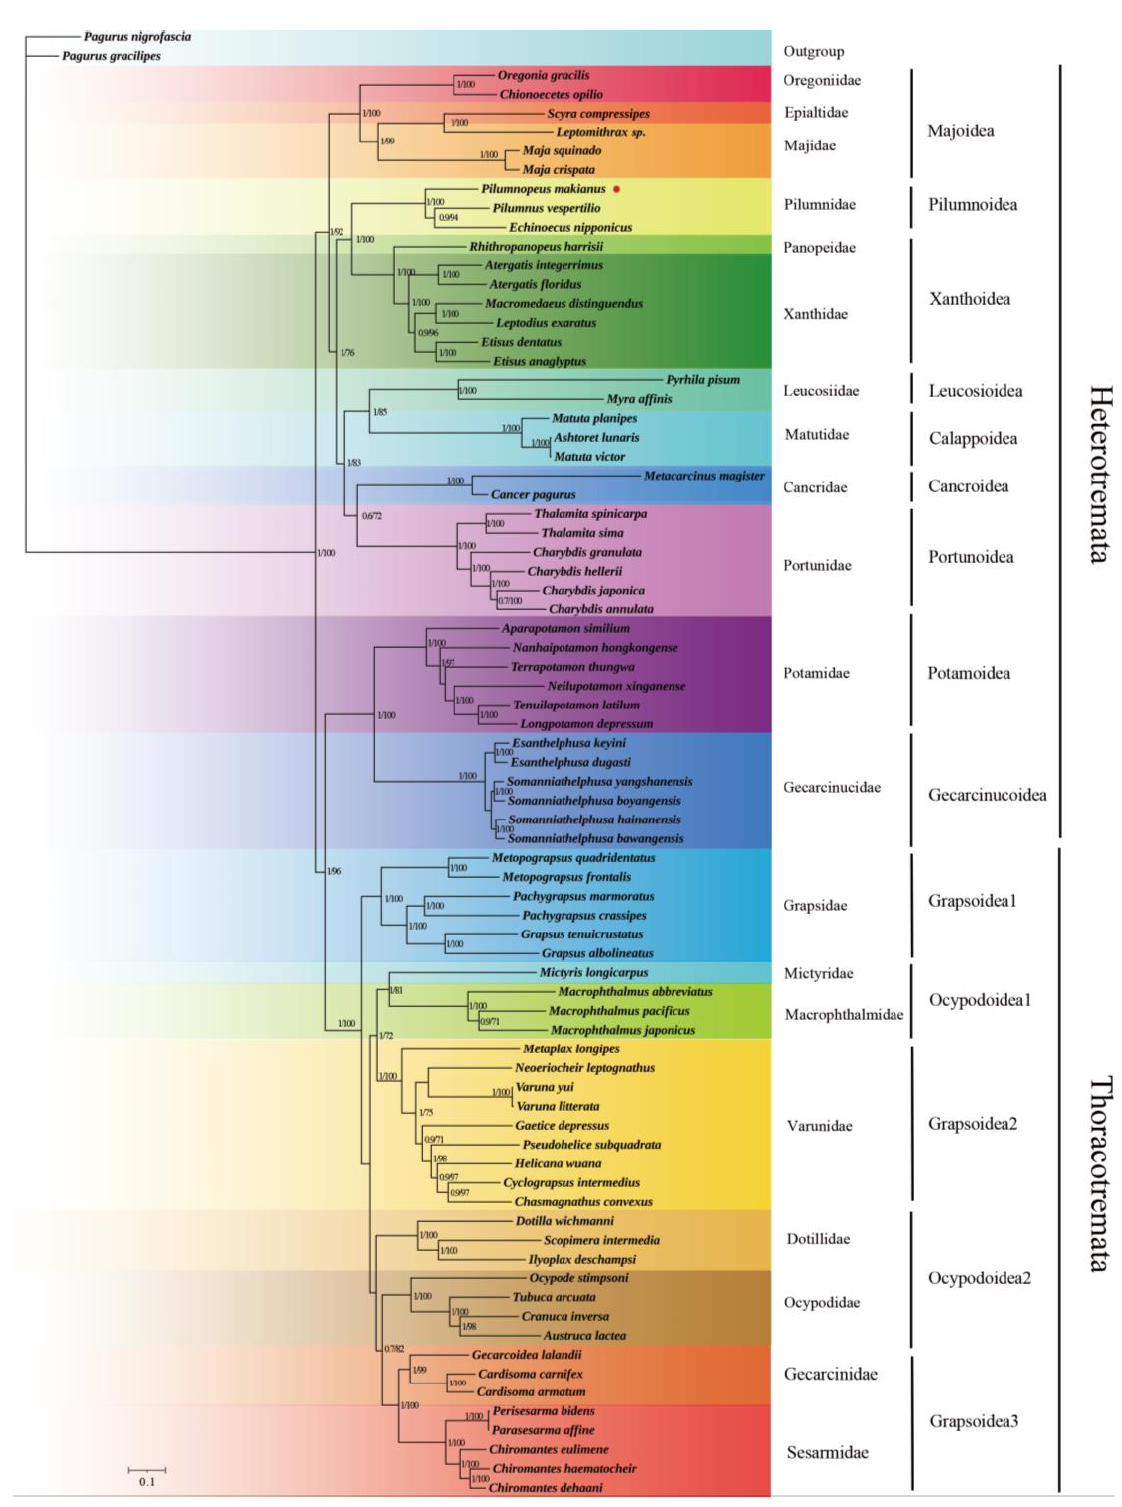
Figure 5. The phylogenetic tree constructed using the 13 PCGs, with BI and ML methods. Num- bers above branches are posterior probabilities from BI (left) and bootstrap percentages from ML (right),